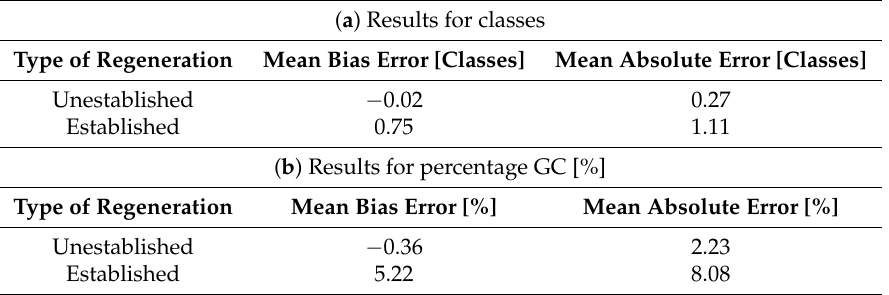
Table 4. Overview of the overall accuracies for unestablished and established regeneration. Subtable ( a ) measures the mean error as number of classes. Subtable ( b ) relates to the same assessment but expresses the error as percentage ground cover, calculated from the ground cover values at the class centres. GC = ground